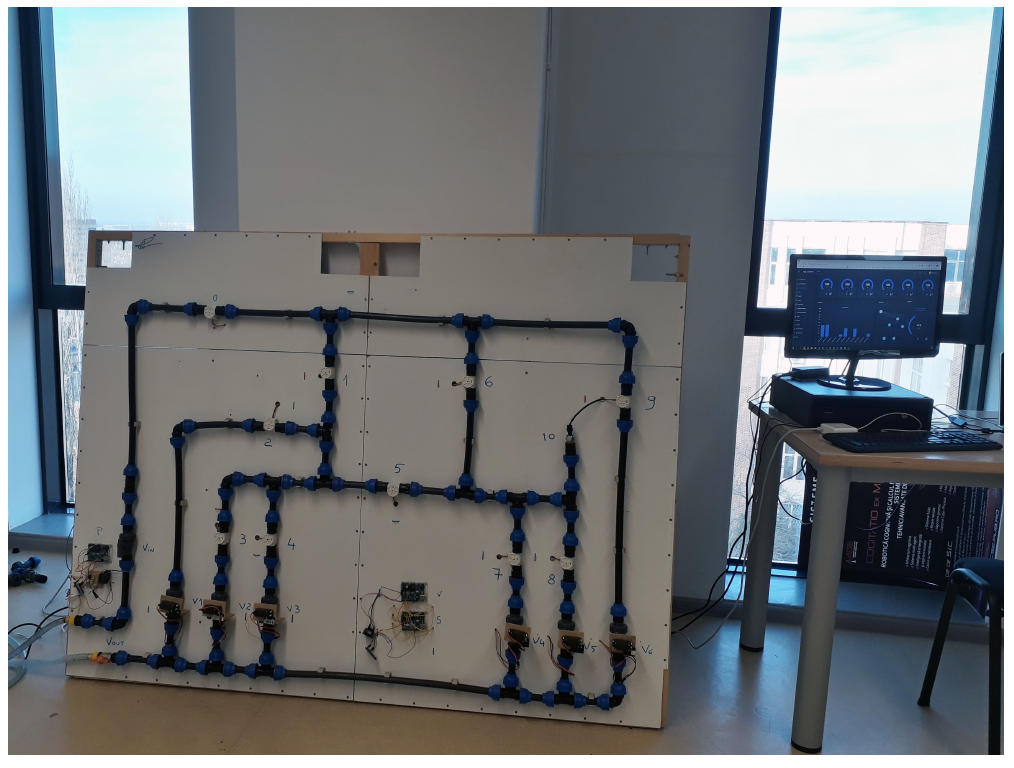
Figure 2. Experimental model.